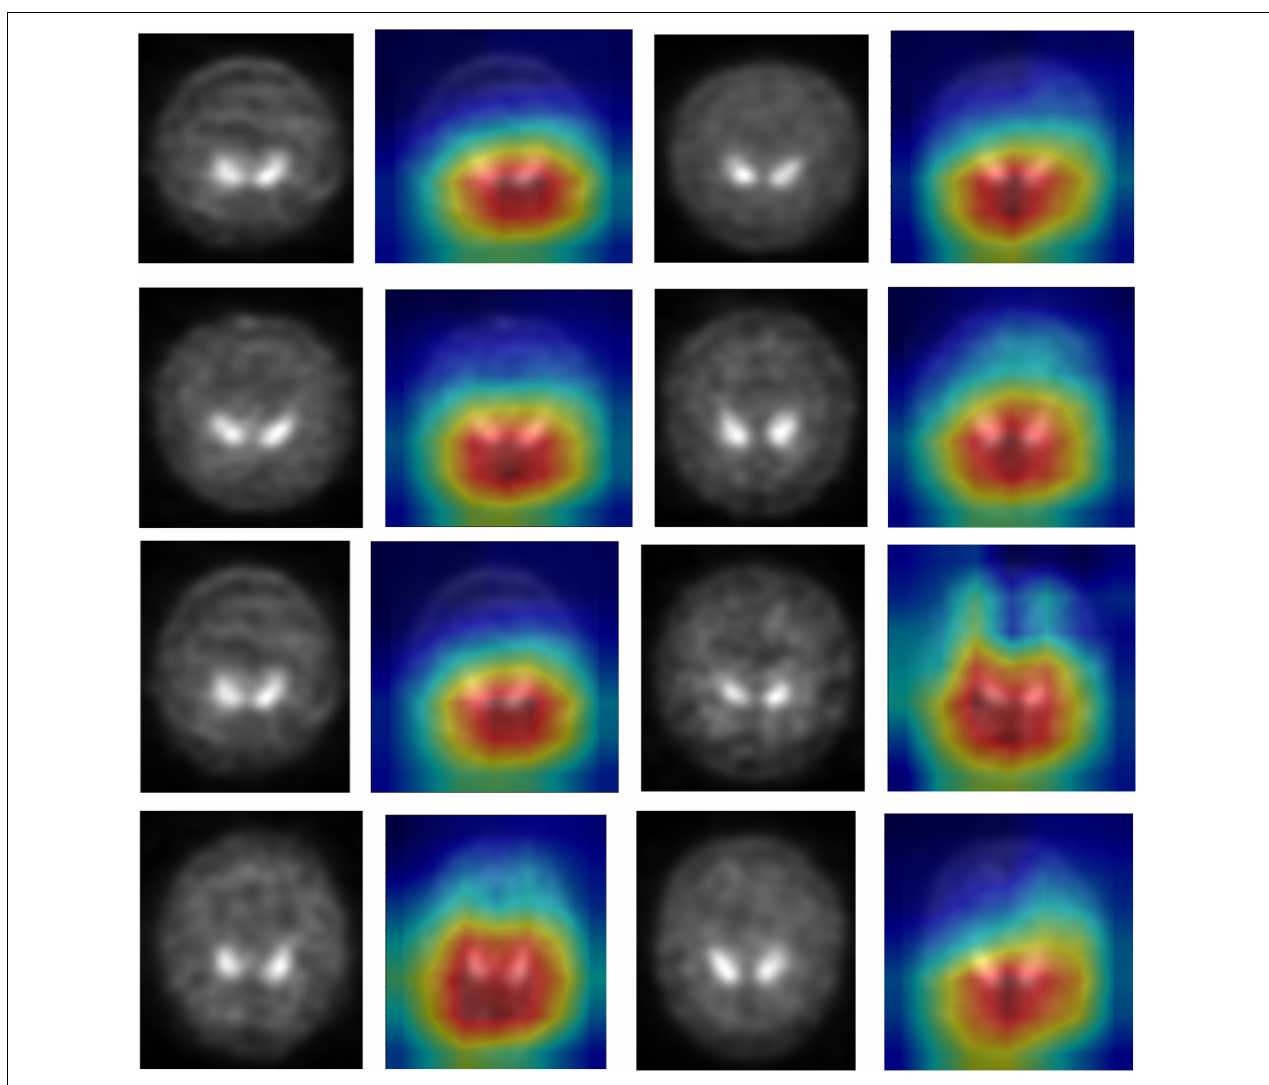
FIGURE 8 | Soft attention map visualisation of HC patients with the ROI highlighted.